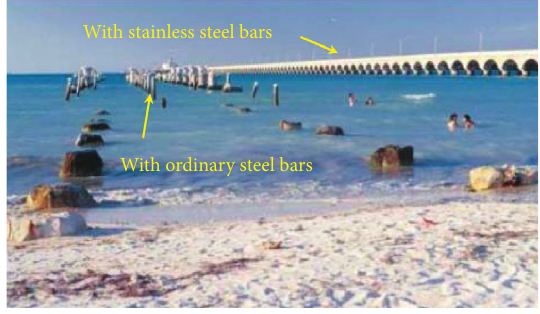
Figure 7: The Progresso pier in Mexico.